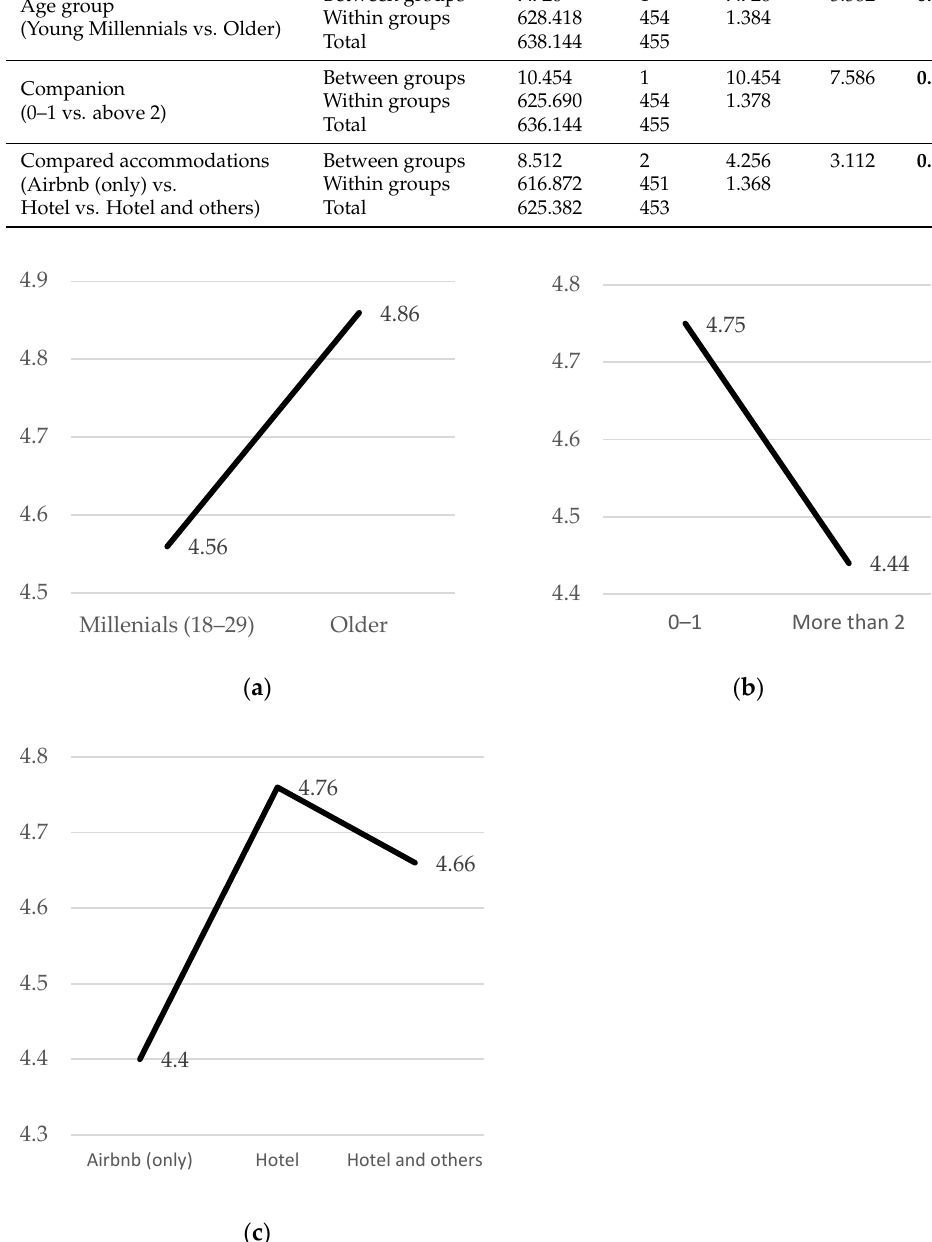
Figure 3. The result of ANOVA (Price perceptions and profiles). ( a ) price perception (y axis) and generation (x axis). ( b ) price perception (y axis) and visit numbers (x axis). ( c ) price perception (y axis) and accommodation type which they compared (x axis).